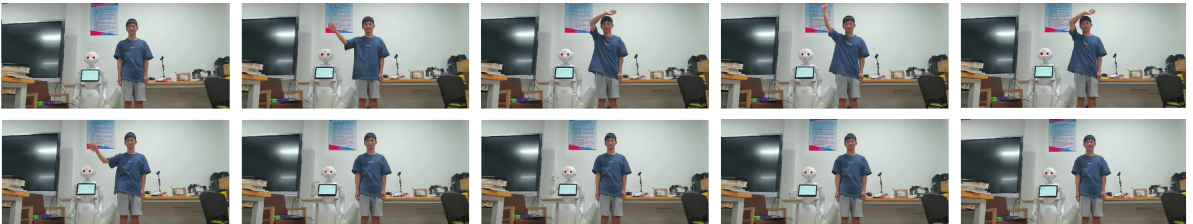
Figure 5: Action interaction with waving the hand as an example.